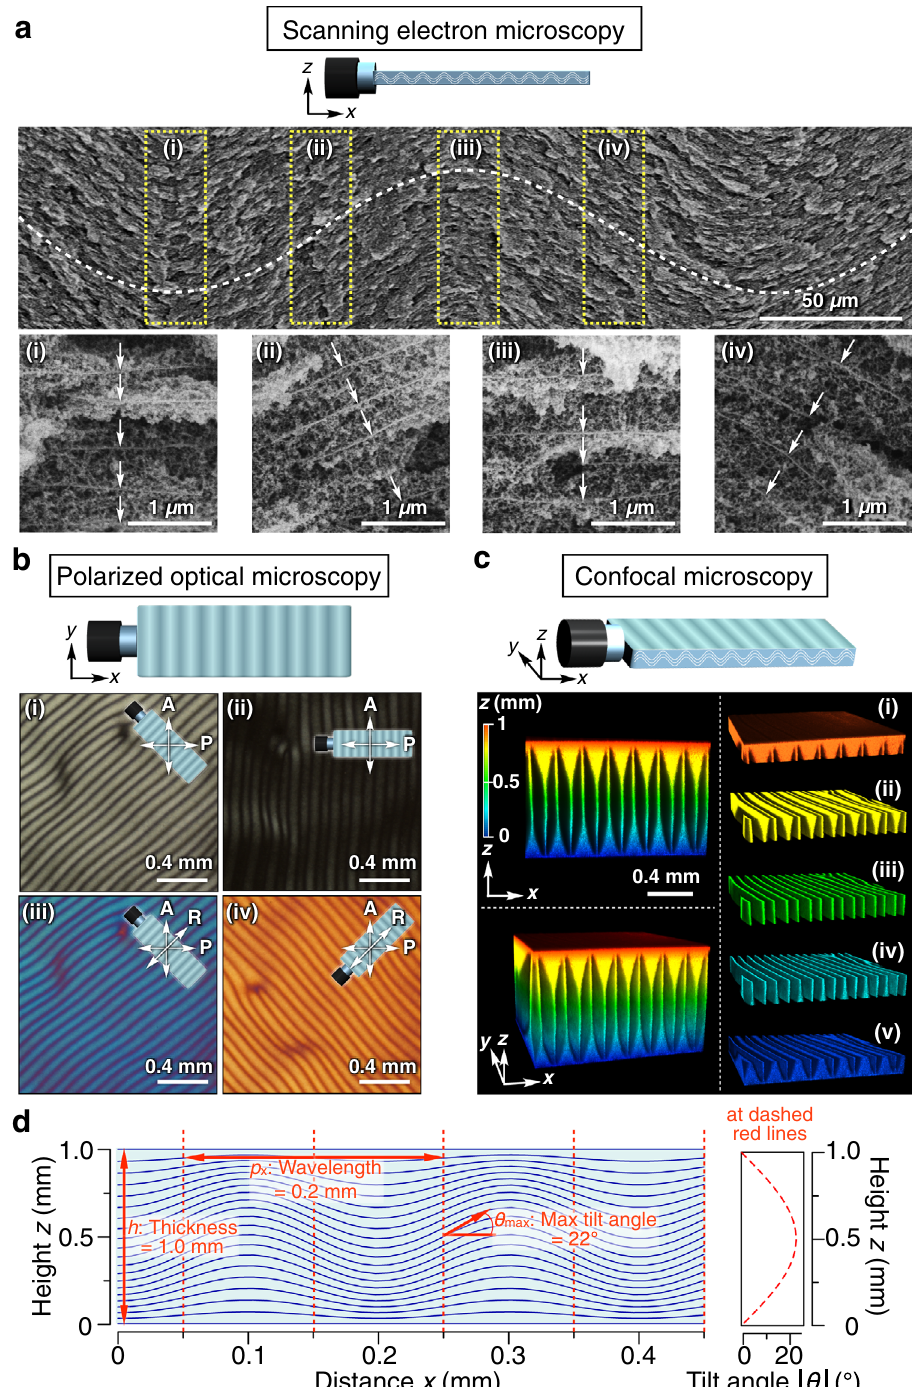
Fig. 2 Structural characteristics of the propagating wave. a Scanning electron microscopy (SEM) visualization of the wave structure of TiNSs, which was fi xed by two-stage in situ polymerization of an acrylic monomer and a silica source, then dried, and subjected to longitudinal – sectional SEM analysis. Low- magni fi cation (upper) and high-magni fi cation (lower, i – iv) images. TiNSs are pointed by white arrows, while a dashed white curve represents their orientation. b Polarized optical microscopic (POM) images under crossed Nicols of the wave structure without (i and ii) and with (iii and iv) a sensitive tint plate. c Confocal laser scanning microscopic (CLSM) images in the re fl ection mode (488 nm laser from the top) of the wave structure. 2D images in the re fl ection mode were taken in a direction parallel to the xy -plane with a z -step size of 2 µ m to reconstitute 3D images, where the bright regions indicate TiNSs that are oriented parallel to the xy -plane. 3D reconstructed image (lower left), its longitudinal-sectional view (upper left), and sliced layers at various heights (right, i – v). In a – c , a magnetically oriented TiNS dispersion of ([TiNS] = 0.5 wt%) in a quartz cuvette (40 × 10 × 1 mm) was left at 25 °C in air (0.04% CO 2 ) to generate the propagating wave. d Theoretically calculated wave structure with TiNSs. Left: Orientation of TiNSs in the longitudinal section of the wave structure, where the TiNS planes are directed along the sinusoidal curves. For better visibility, amplitudes of the sinusoidal curves are magni fi ed fi ve times. Right: Tilting angle θ of TiNSs (right) along the dashed red